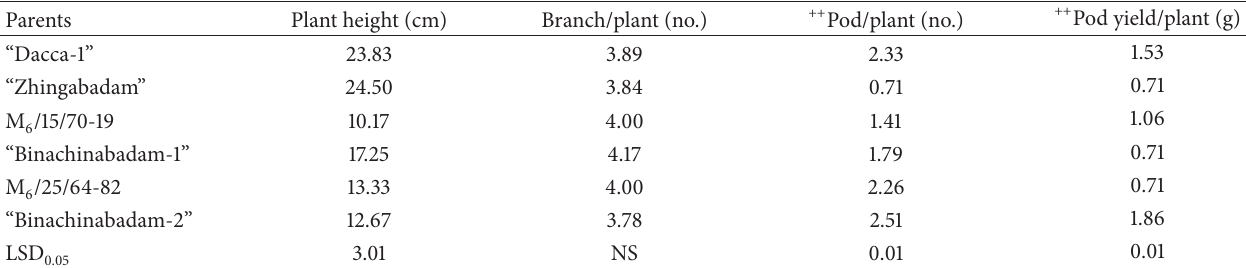
Table 4: Means of pod yield and related traits of the parents as influenced by 8 dS/m salinity imposed during flowering till harvest stages. Parents Plant height (cm)